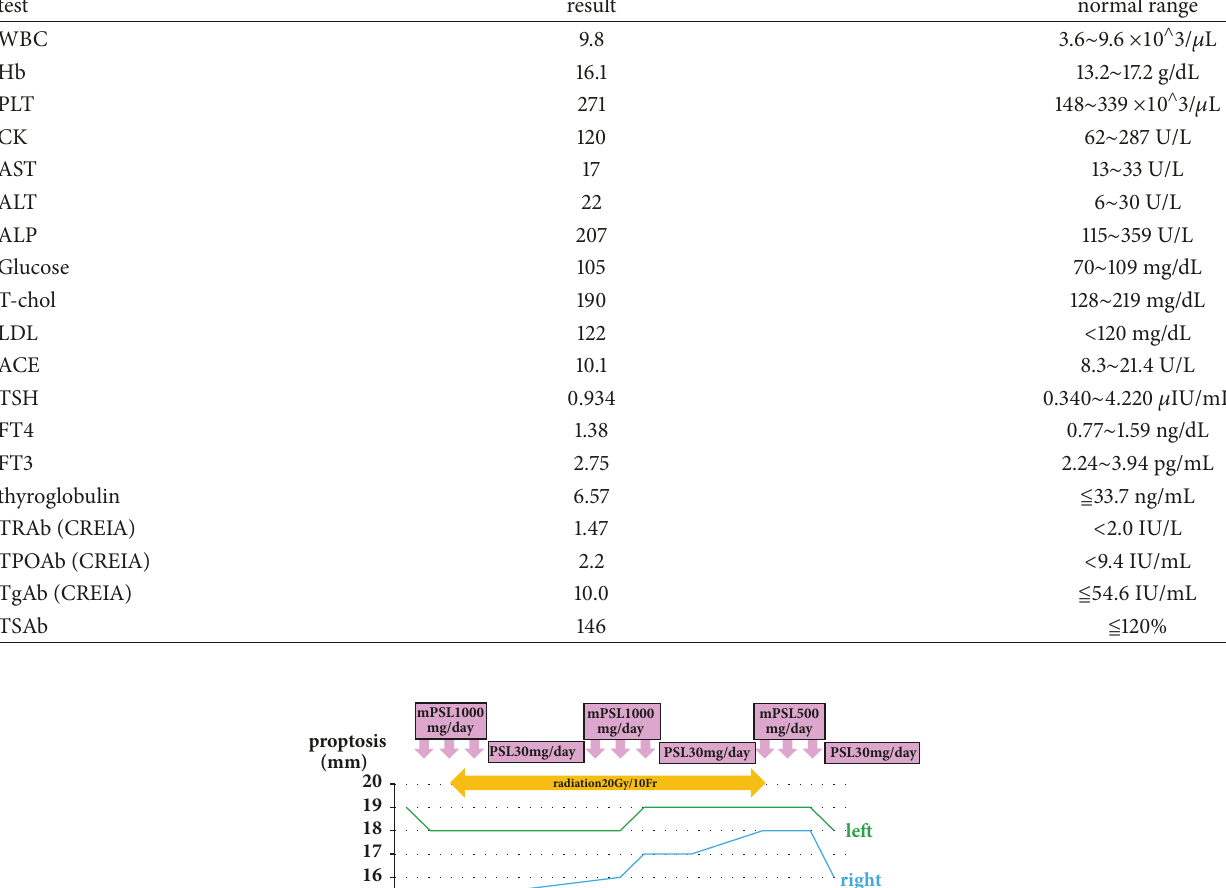
Table 1: Laboratory data at presentation.